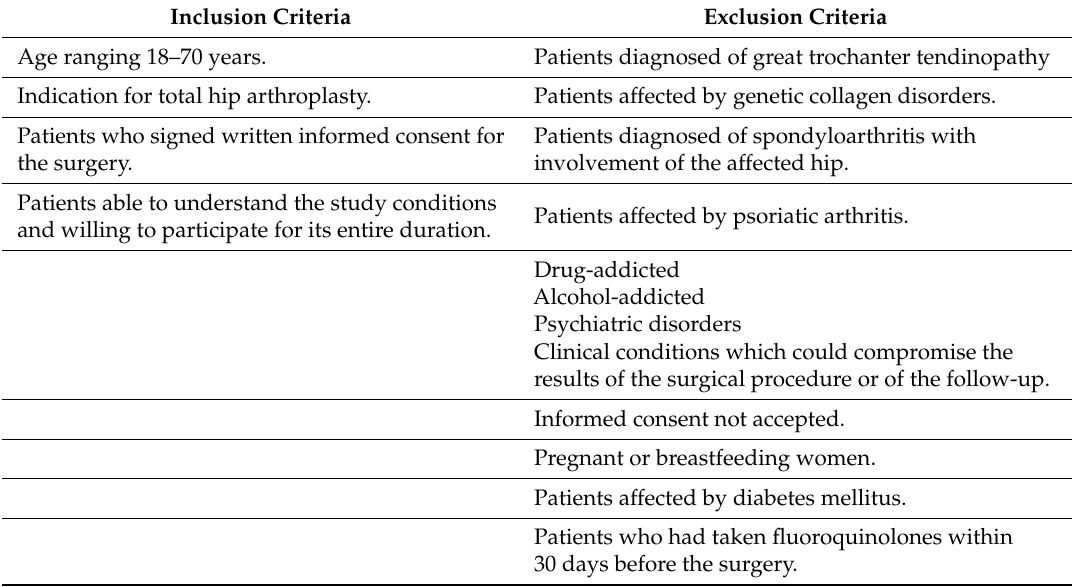
Table 1. Eligibility